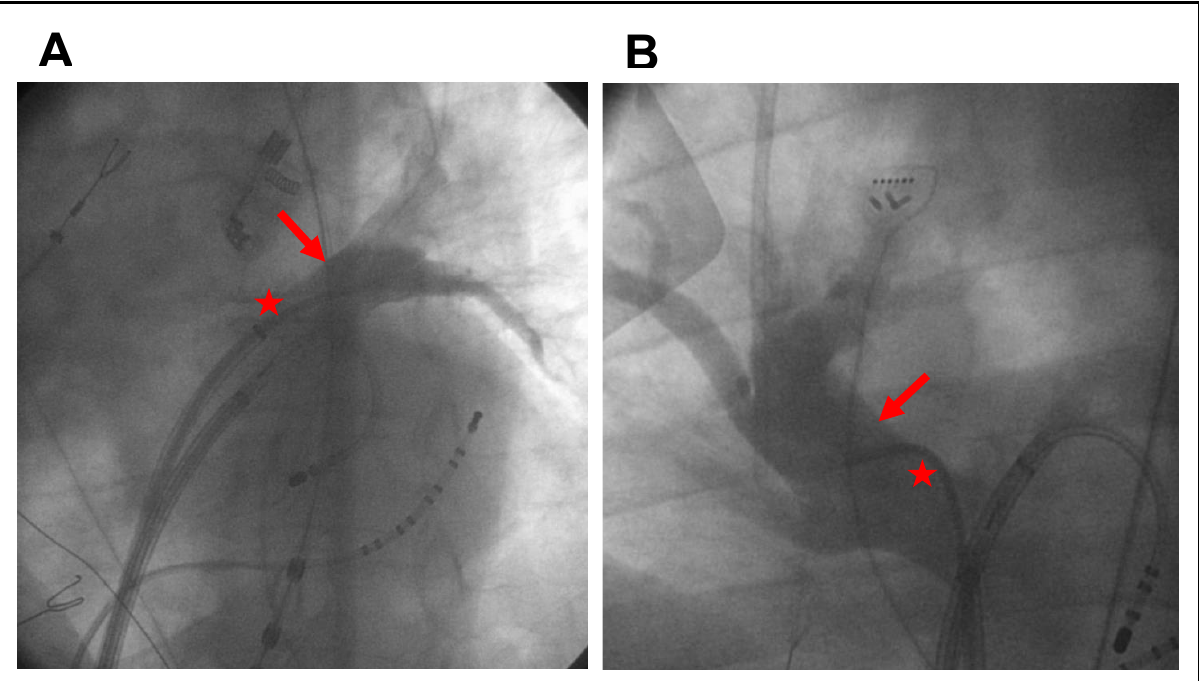
Figure 1. Examples of intraprocedural pulmonary vein angiography (arrows). ( A ) shows the left superior pulmonary vein at 40° LAO, and ( B ) shows the right superior pulmonary vein at 30° RAO. The MP-1 catheter was inserted via a transseptal sheath (asterisks).